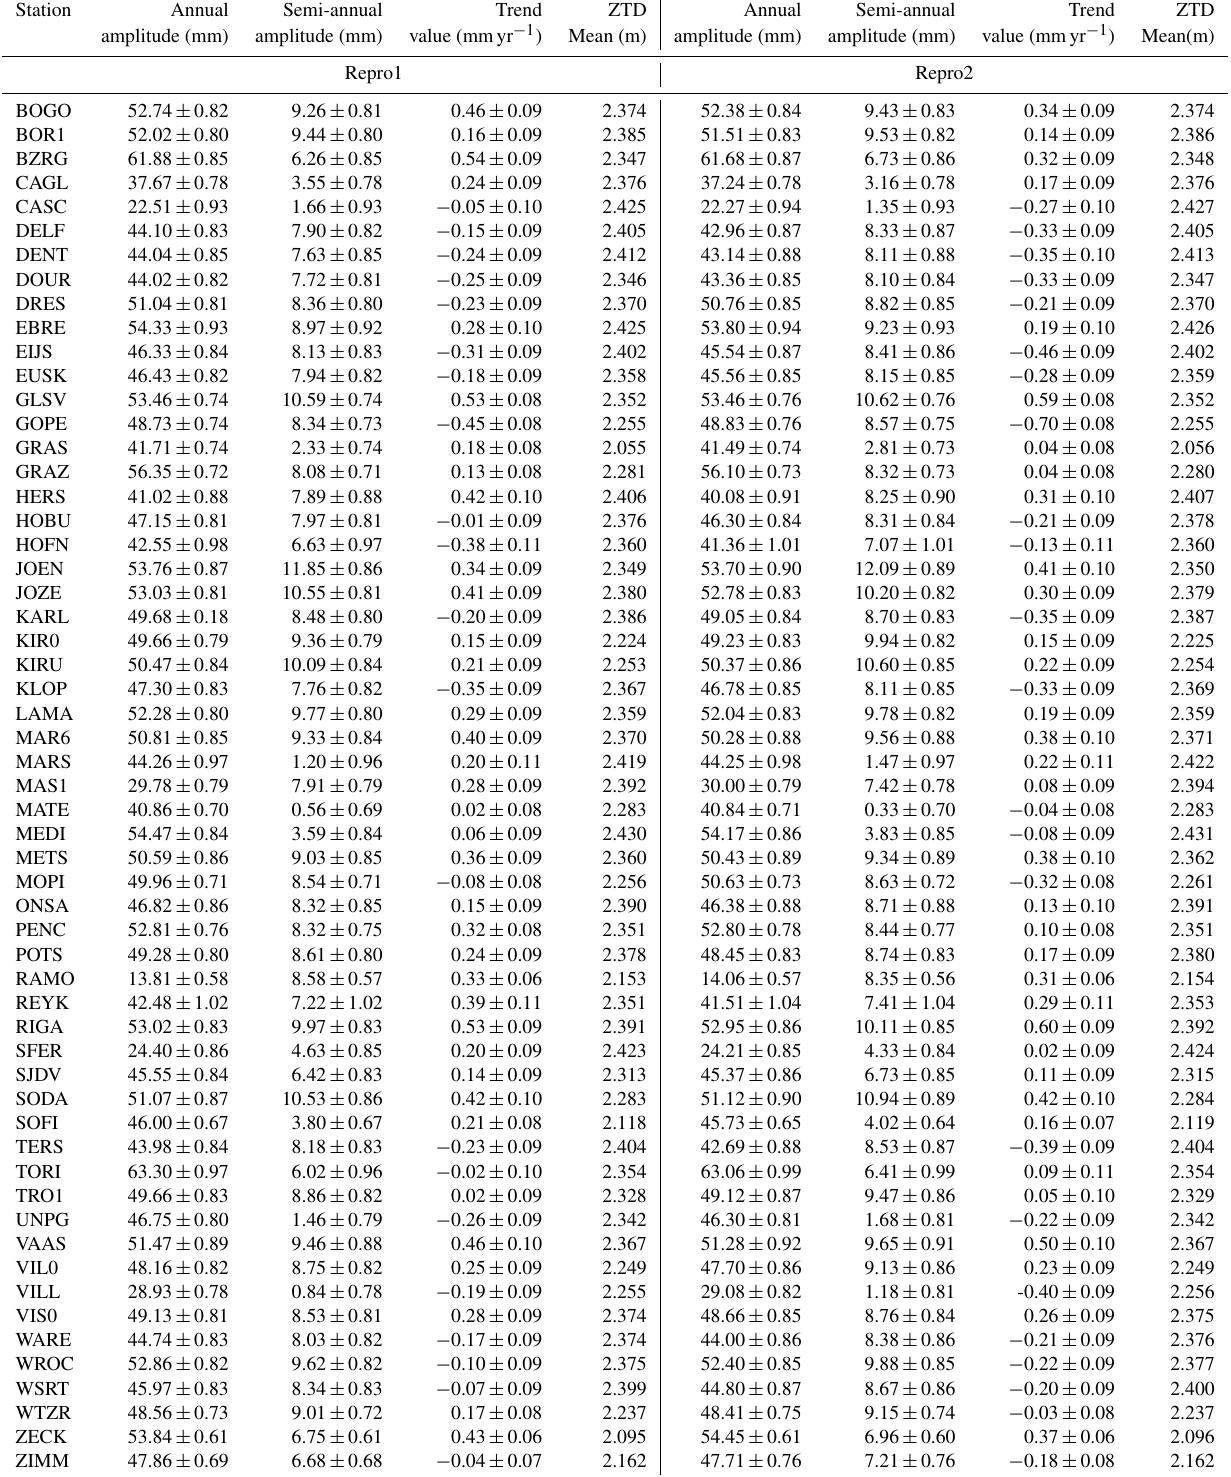
Table A1. Results of analysis of the 16-year ZTD time series from the first (Repro1) and the second (Repro2) EPN reprocessing campaigns.